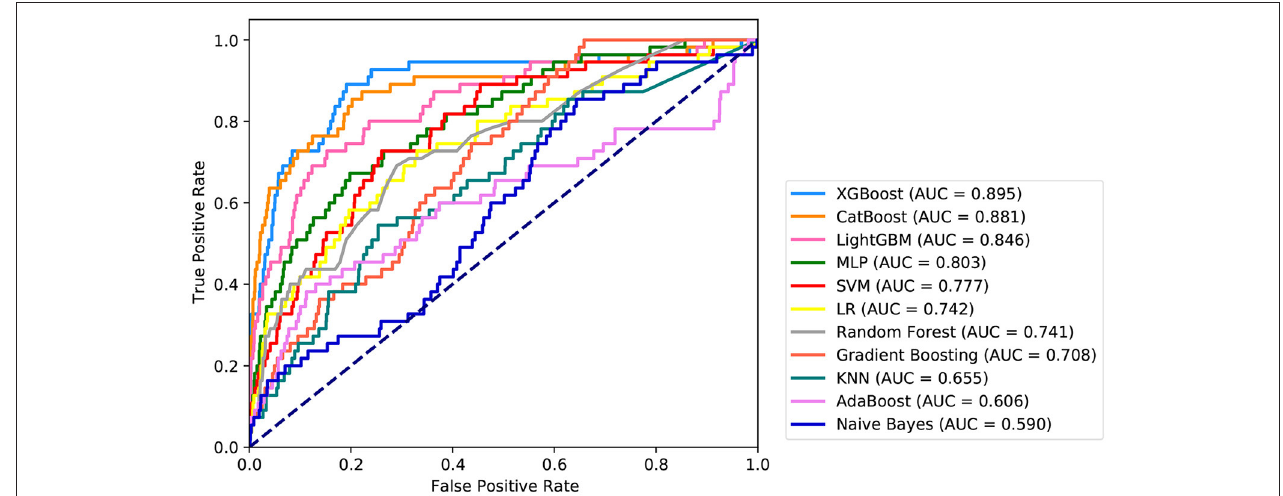
FIGURE 2 | Receiver operating characteristic curves for the machine learning model and logistic regression. XGBOOST, eXtremely Gradient Boosting; CatBoost, Categorical Boosting; LightGBM, Light Gradient Boosting; MLP, Multi-Layer Perceptron; SVM, Support Vector Machine; LR, Logistic Regression; KNN, K-Nearest Neighbor; AdaBoost, Adaptive boosting.